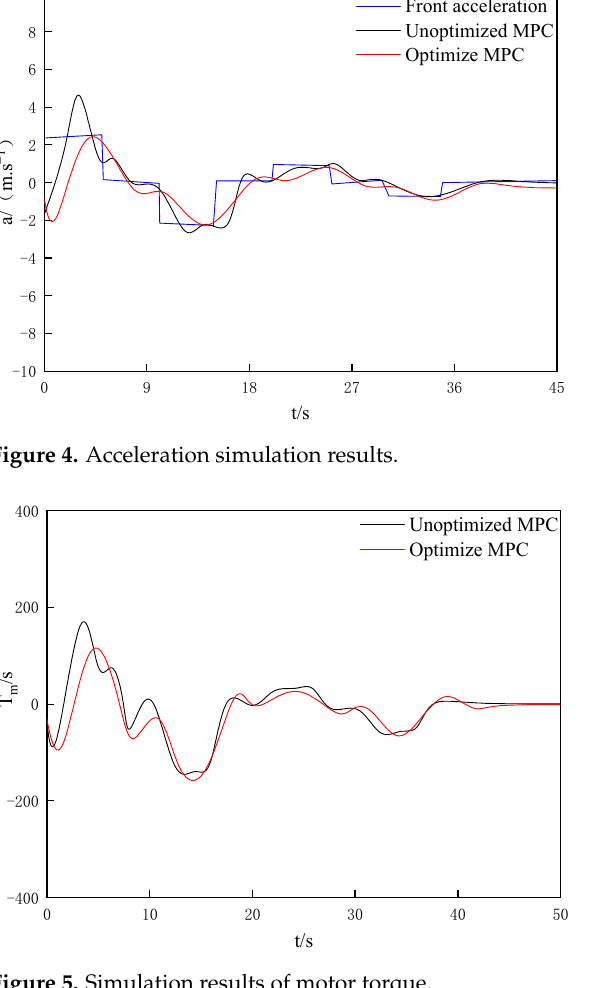
Figure 5. Simulation results of motor torque.